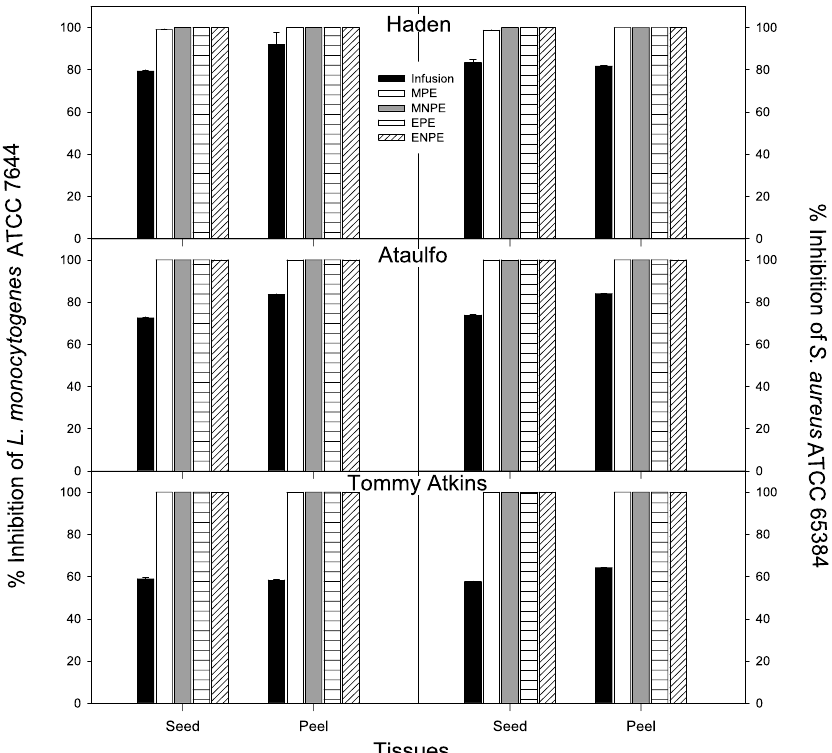
Fig. 5: Percentage of inhibition of gram positive bacterial strains exposed to bioactive extracts from fresh-cut mango byproducts. *Concentration 25 mg/mL. **Average of three determinations ± standard